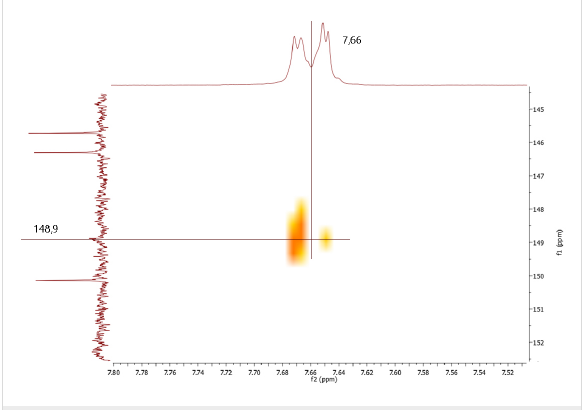
Figure 2: Detail of the hydrazone signal in the HMBC spectrum of THBER 3a